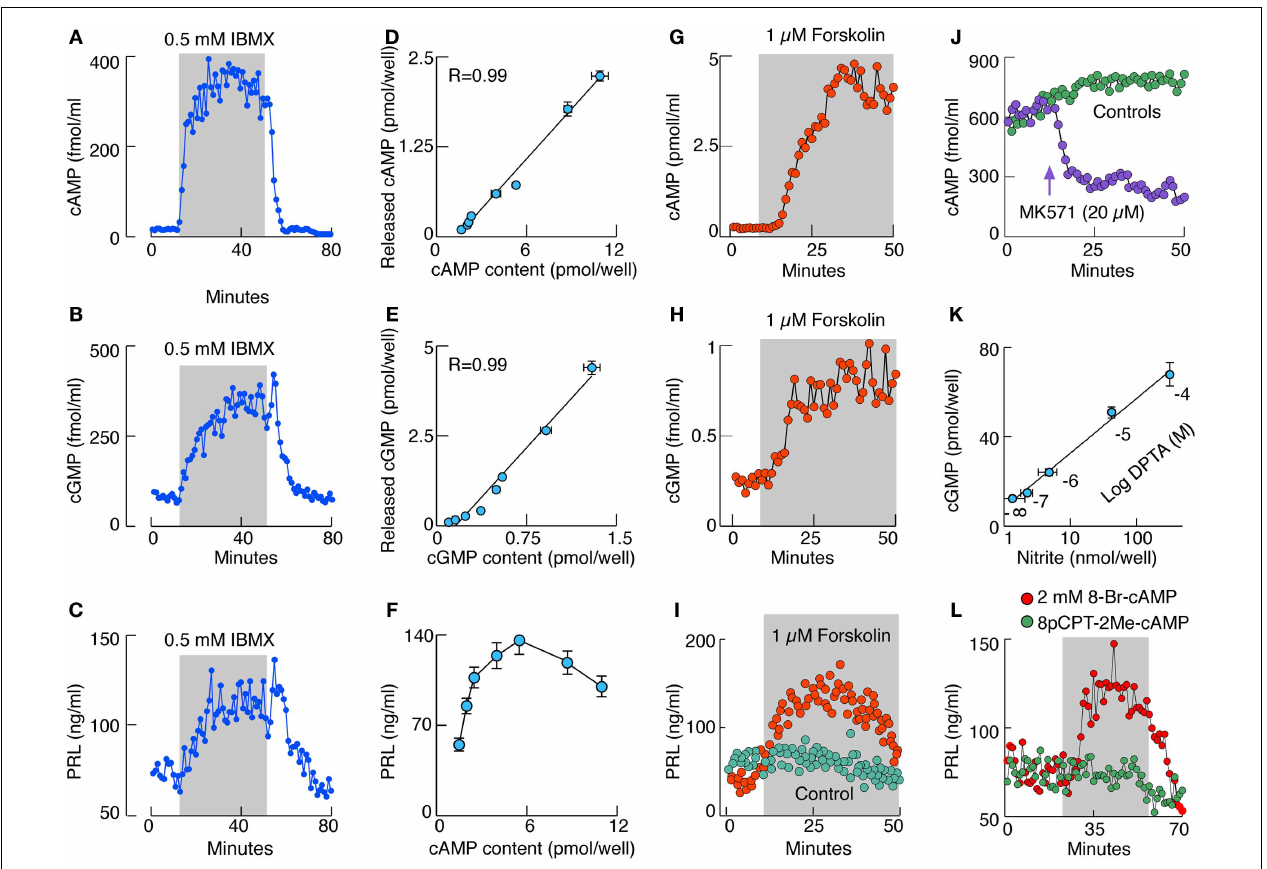
FIGURE 1 | Characterization of cyclic nucleotide signaling pathways in rat anterior pituitary cells in vitro . (A–C) Effect of IBMX, a PDEs inhibitor, on cAMP (A) , cGMP (B) , and PRL (C) release by perifused pituitary cells. (D,E) Correlation between released and cell content cAMP (D) and cGMP (E) in cells in static cultures treated with variable concentrations of IBMX. R, coefficient of correlation. (F) The relationship between cAMP intracellular content and PRL release. (G–I) Effects of forskolin, an AC activator, on cAMP